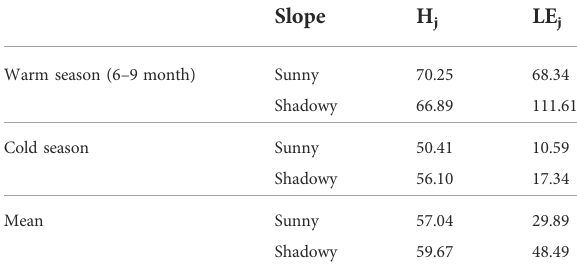
TABLE 2 Average sensible and latent heat fl uxes in cold and warm seasons on the shadowy and sunny